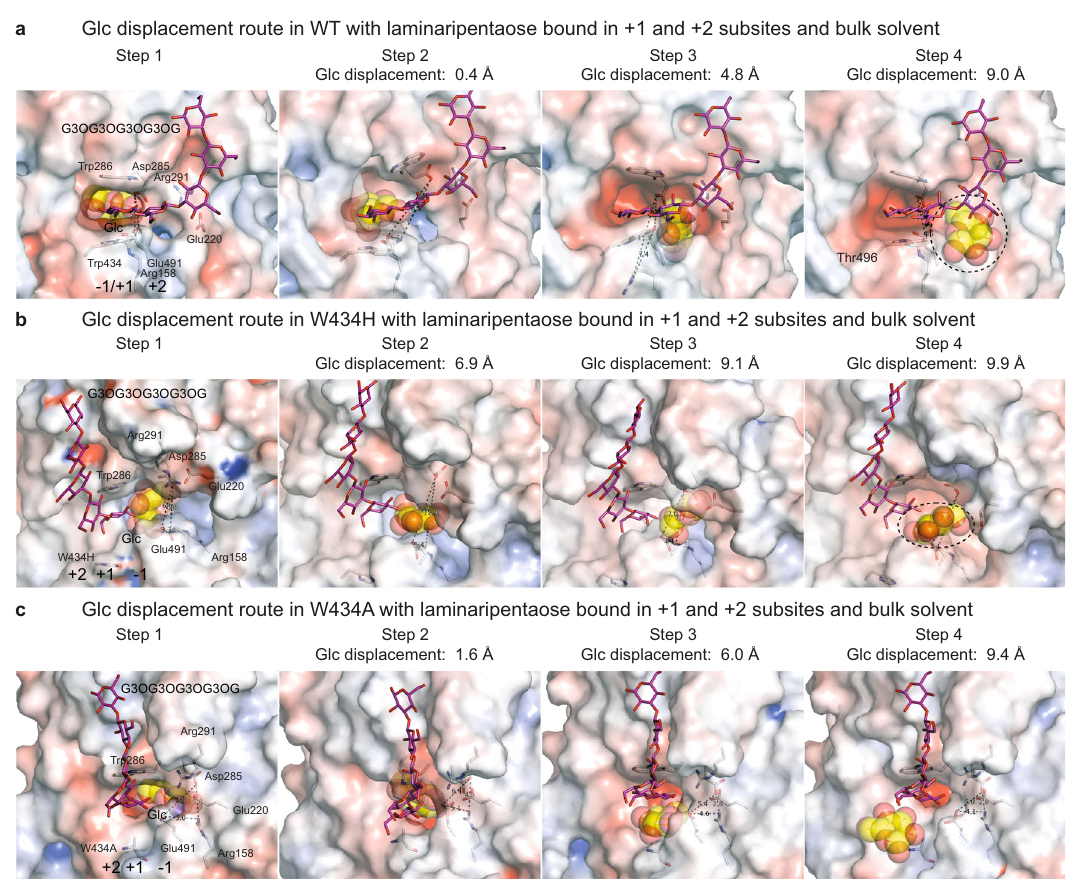
Fig. 7| Glcdisplacement routesin WT,andtheW434H,andW434A mutantsof HvExoI with Glc and laminaripentaose, calculated through cMD and GPath- Finder.a WT; b W434H; c W434A – FourstepsalongGlcdisplacementroutesbased on converged structures in complex with Glc ( − 1 subsite; carbons in cpk yellow lines, and spheres) and laminaripentaose (+1 and +2 subsites and bulk solvent; carbons: magenta sticks) obtained by docking. Selected residues (carbons: atomic sticks), and positions of Glc, and laminaripentaose are indicated. Glc in the − 1 subsite is separated from the lateral cavity that is evolving during Glc egress by